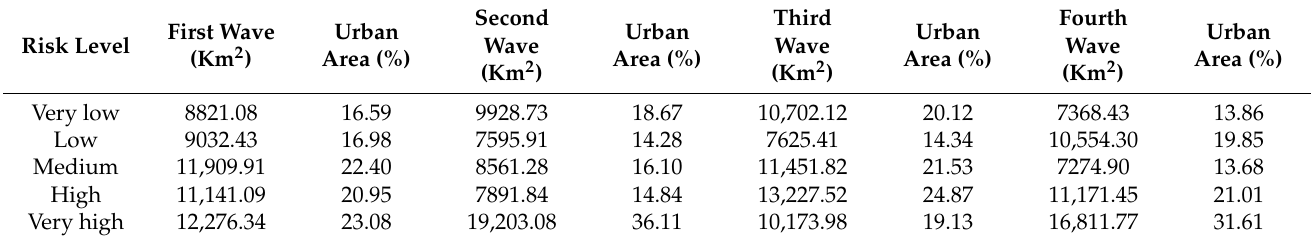
Table 2. Area (Km 2 ) according to the level of contagion risk in the urban area (total area: 53,180.85 Km 2 ) analyzed during the four waves of